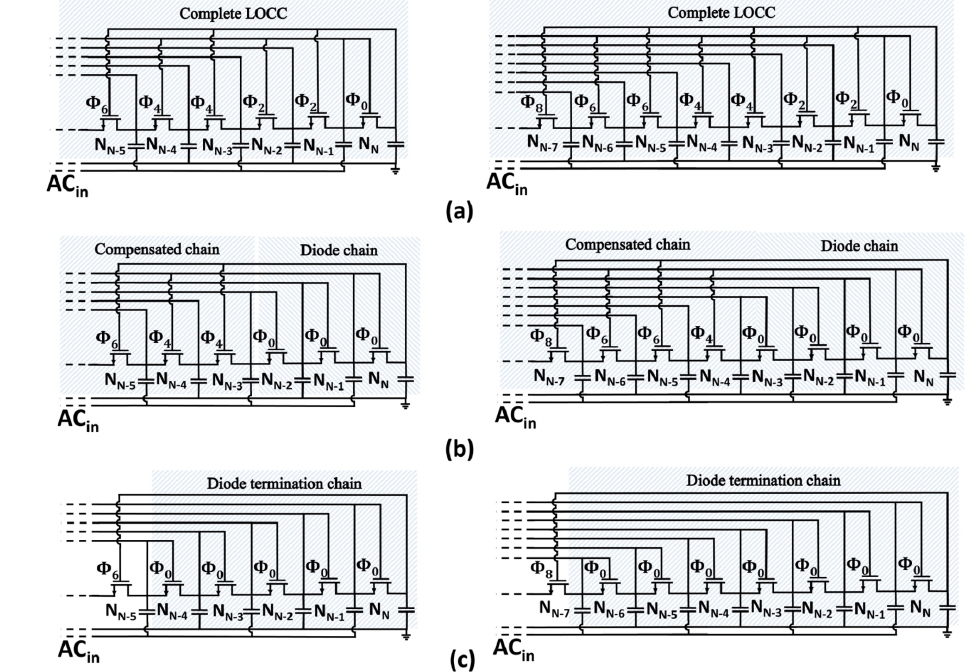
Figure 11. Circuit schematic of NMOS termination chains comprising: ( a ) a complete LOCC, ( b ) a diode chain and a compensated chain, ( c ) only diode-connected